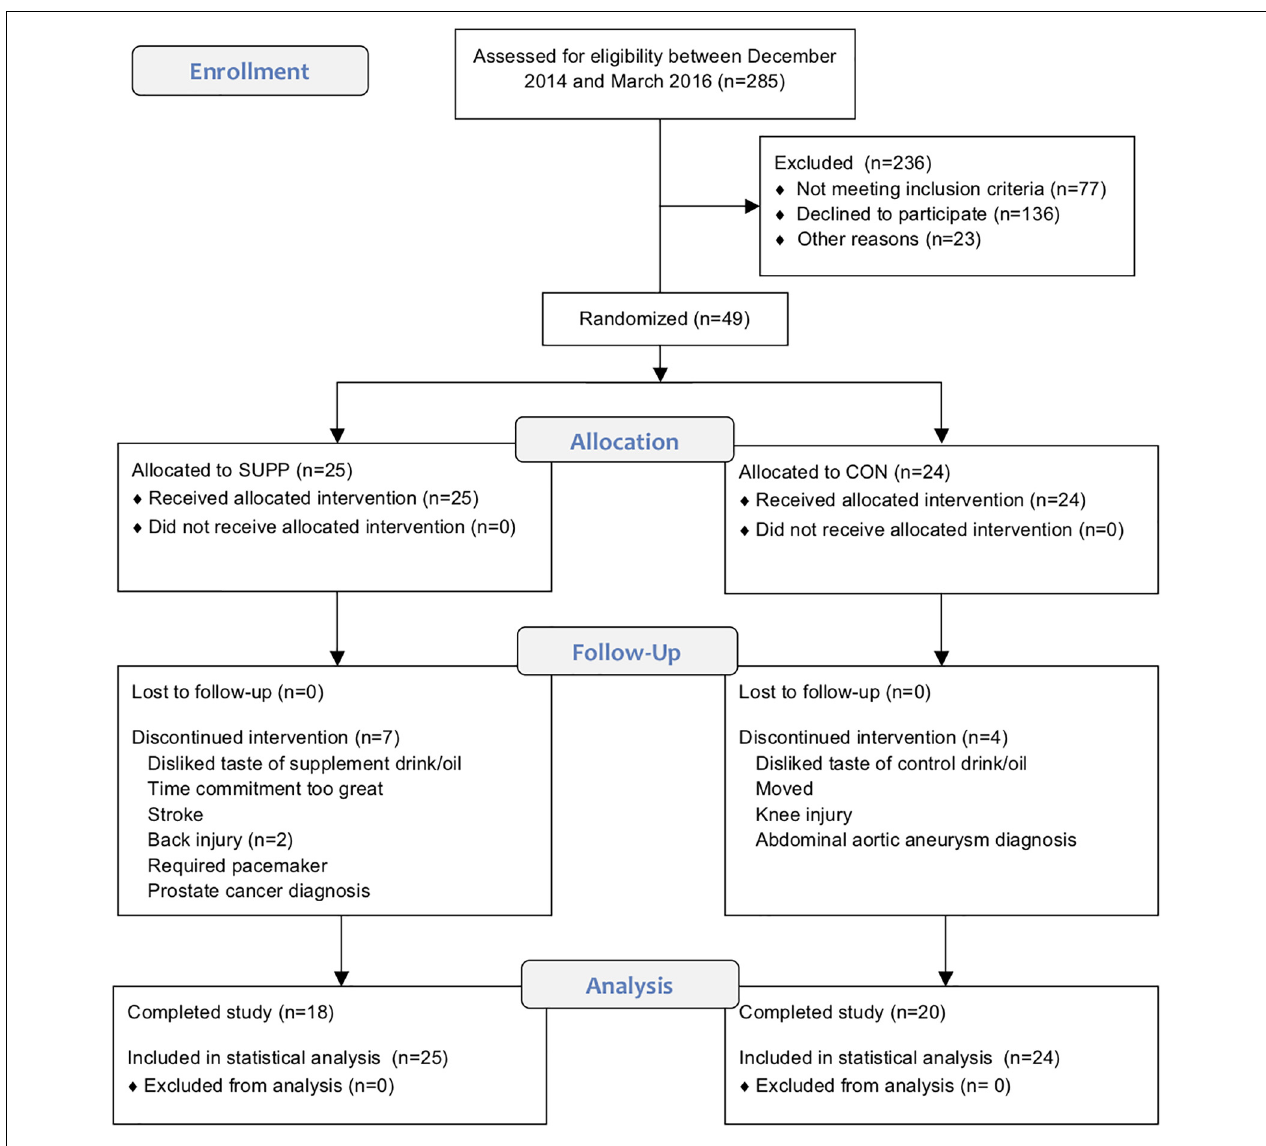
FIGURE 1 | CONSORT flow diagram. This chart depicts the movement of participants through the trial, which we conducted between December 2014 and September